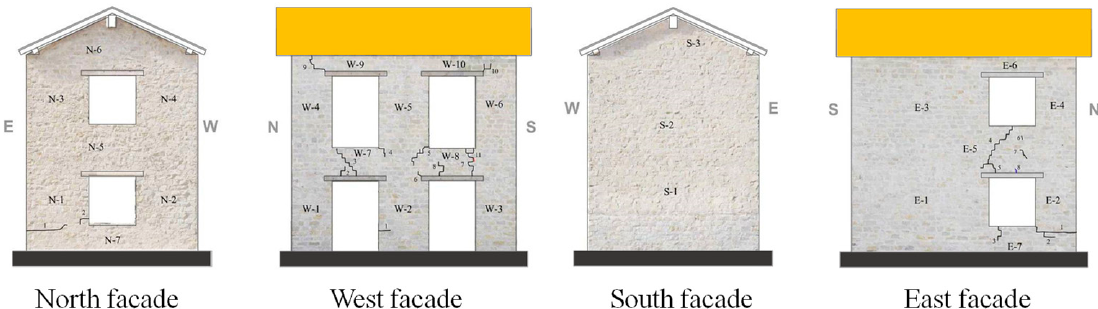
Figure 3. Crack pattern during test phases T1–T3: cracks shown in black . The test T 5 performed at a nominal PGA of 0.40 g (and an actual one at 0.629 g, as shown in Figure 2) reached a close to the collapse state (Figure 4). The collapse mechanism had been already formed in the previous test phase T 4 at a nominal PGA of 0.30 g (actual PGA = 0.509 g), where the west wall presented stepped diagonal cracks at its top and bottom of the second-floor north pier, as shown with black lines in Figure 4. The collapse mechanism involved the upper part of the north façade (perpendicular to the excitation), which tended to overturn out-of-plane, the two spandrel beams and wooden lintels on the west and east walls (parallel to the seismic excitation), which rotated and slid on the lintel support, and the gable wall of the south façade, which also tended to overturn following the motion of the north wall due to their connection through the ridge beam (Figure 4). The stationary tests preceded each strong motion tests and a final stationary test S 5 followed the strong motion test T 5 . However, it should be noted that at this test, the structure was mildly reinforced with ties to prevent a total collapse of the